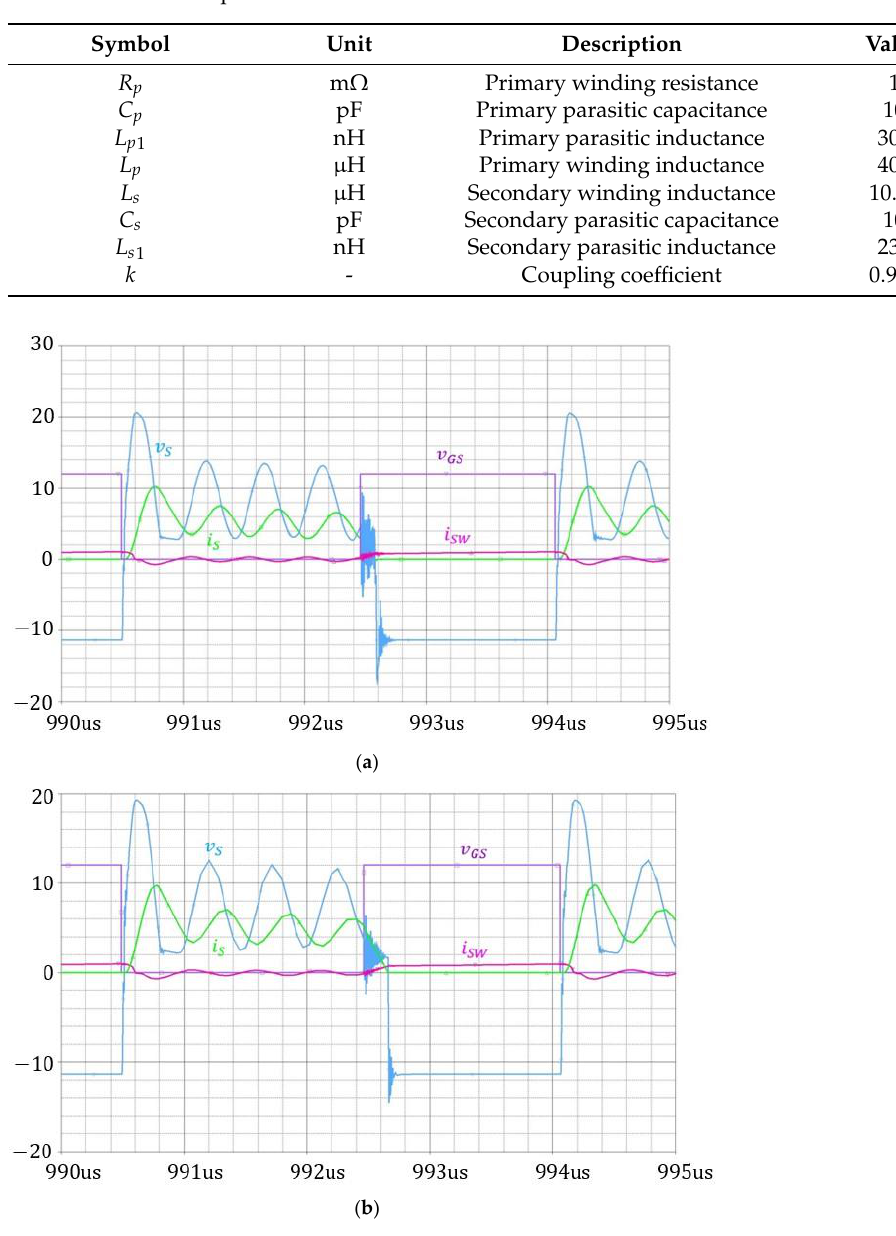
Figure 10. Simulation results with ( a ) rectifier diode and ( b ) GaN HEMT synchronous rectifier. Table 8. Transformer parameters in SPICE Simulation.